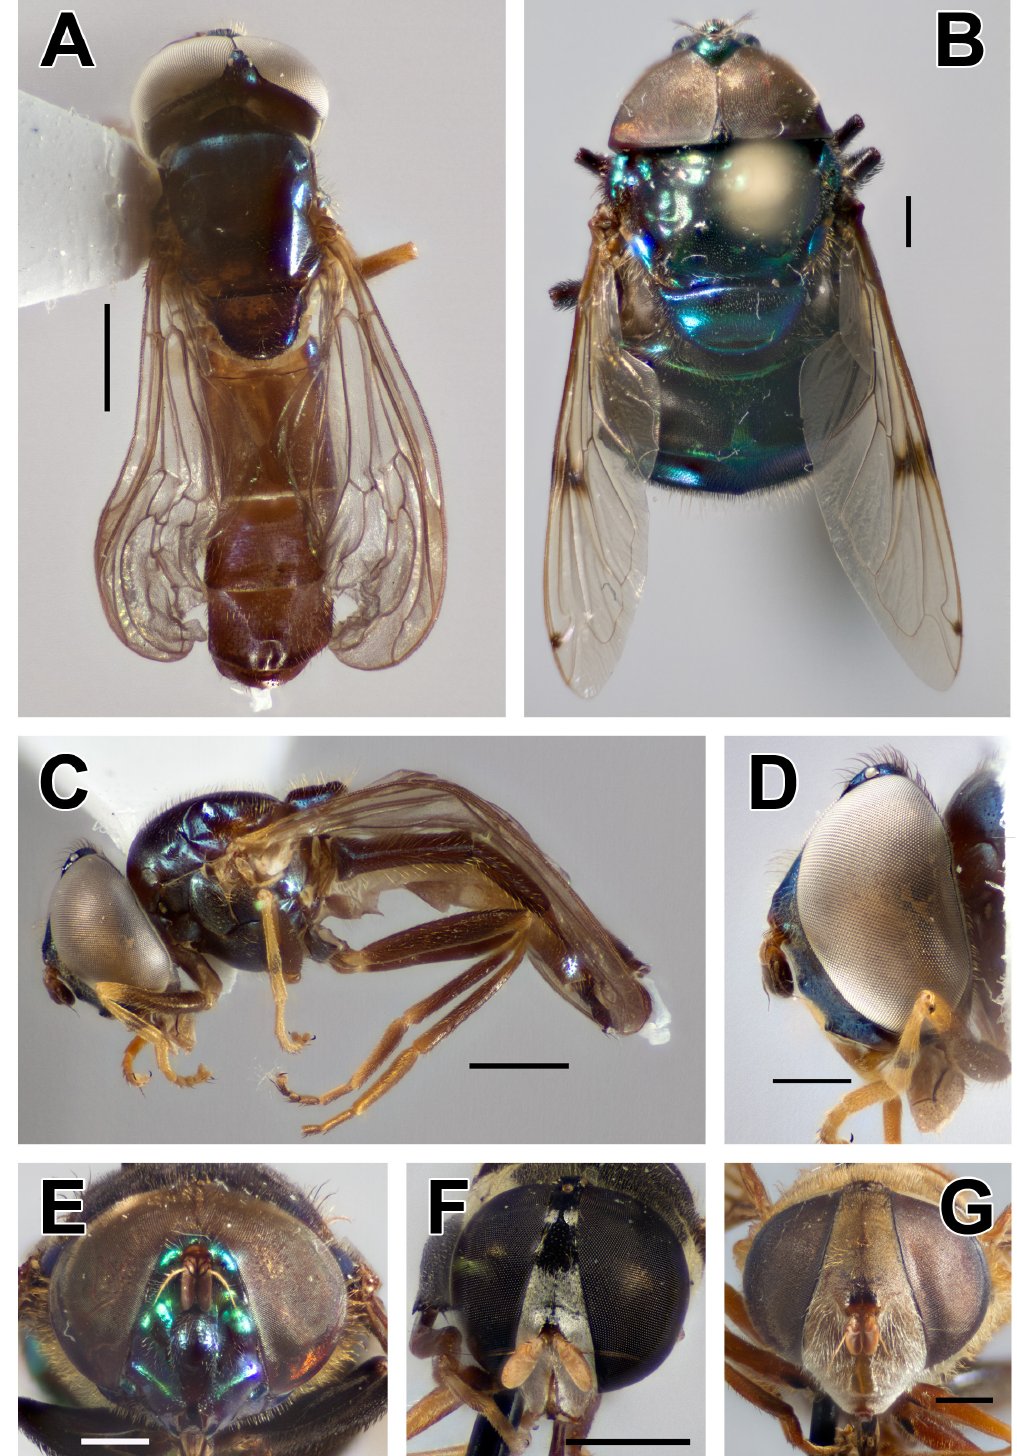
Fig. 4. A, C–D . Melanostoma polynesiotes Mengual & Ramage sp. nov., holotype, ♂ (ZFMK- DIP-00019707). A. Lateral view. C. Lateral view. D. Head, lateral view. B, E . Ornidia obesa (Fabricius, 1775), ♂ (ZFMK-DIP-00019747). B. Dorsal view. E. Frontal view. F . Syritta aenigmatopatria Hardy, 1964, ♀ (ZFMK-DIP-00019739), frontal view. G . Palpada vinetorum (Fabricius, 1798), ♀ (ZFMK- DIP-00019738), frontal view. Scale bars = 1